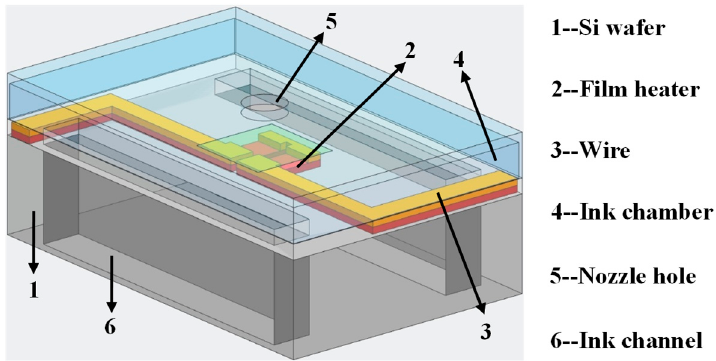
Figure 1. 3D model of the inkjet printhead with a single nozzle.